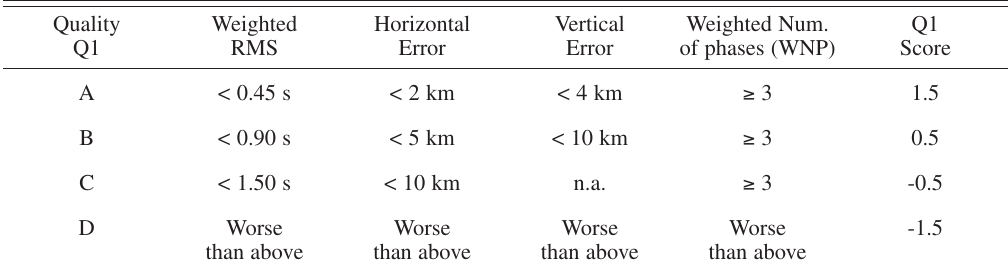
Table III. Quality Ranking Q1 used to class hypocenters according to goodness-of-fit and formal errors. An earthquake has quality D if at least one of the conditions is not verified. The WNP value results from the sum of the relative weights (which can range between 0.0 and.1.0) assigned to the associated arrival times. The score shown in the last column is used in combination with Q2 score (see table IV) to define a unique quality scale used in fig. 9.